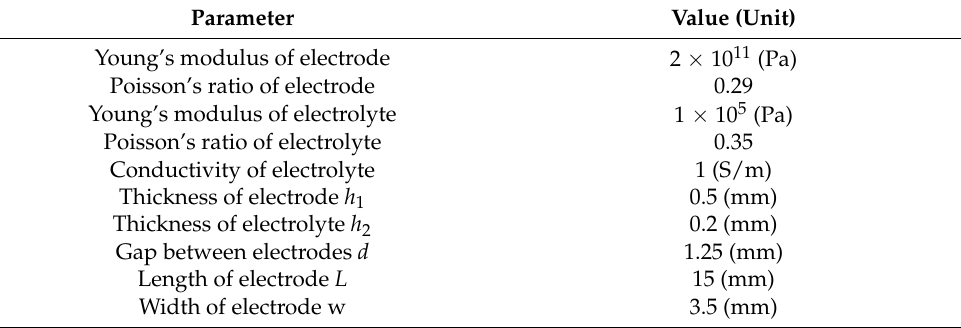
Table 1. Key parameters used in the simulation.